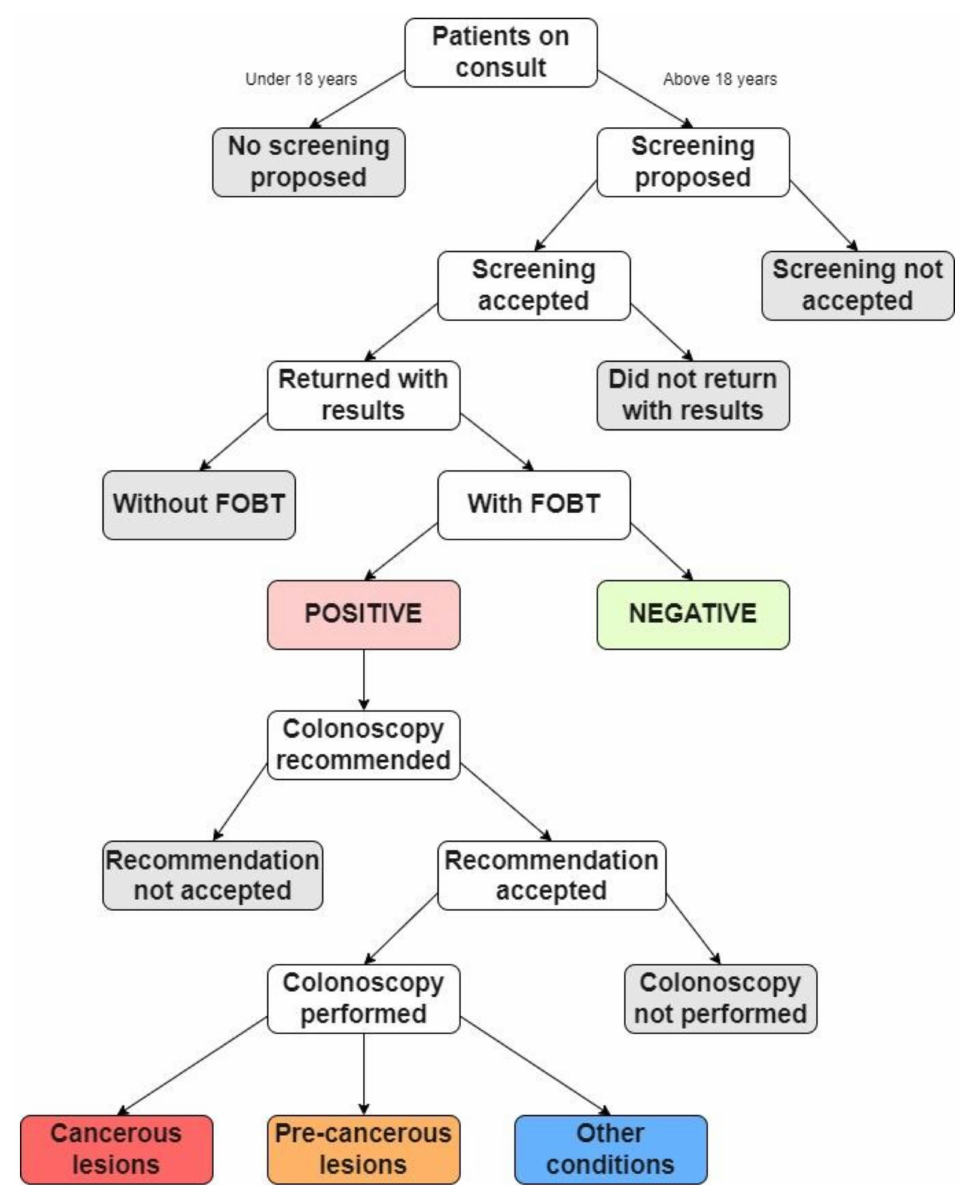
Figure 1. Flow chart summarizing the study’s